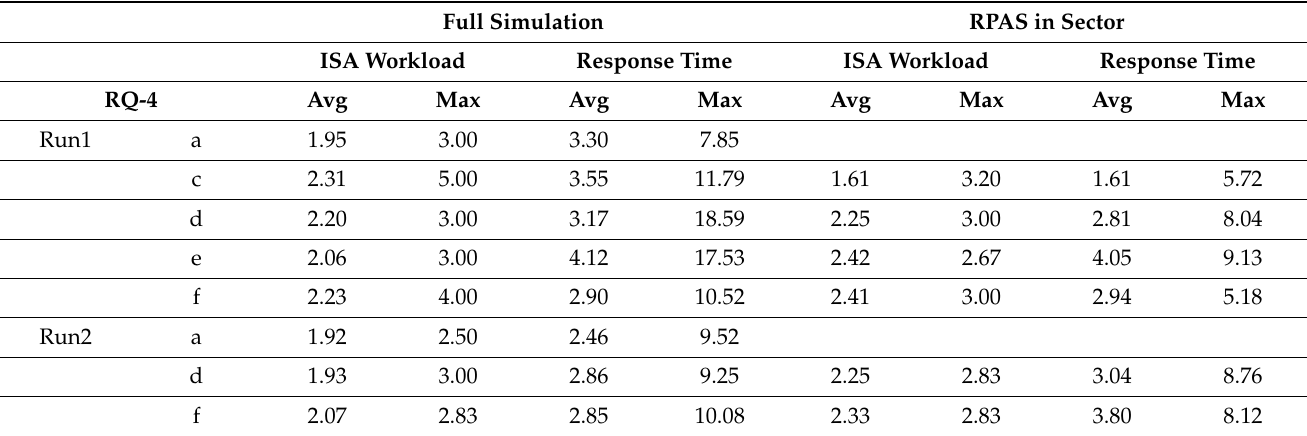
Table 11. ISA data recording for the RQ-4A contingency simulations.